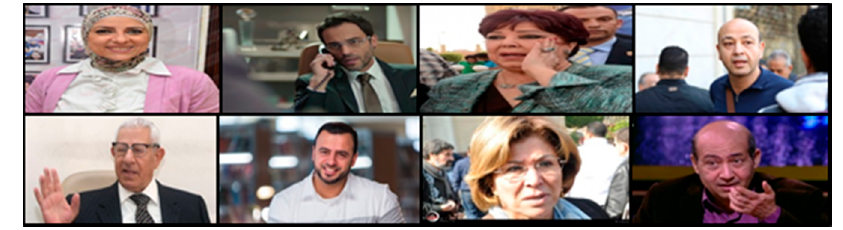
Figure 8. Face images in Arabian faces dataset.